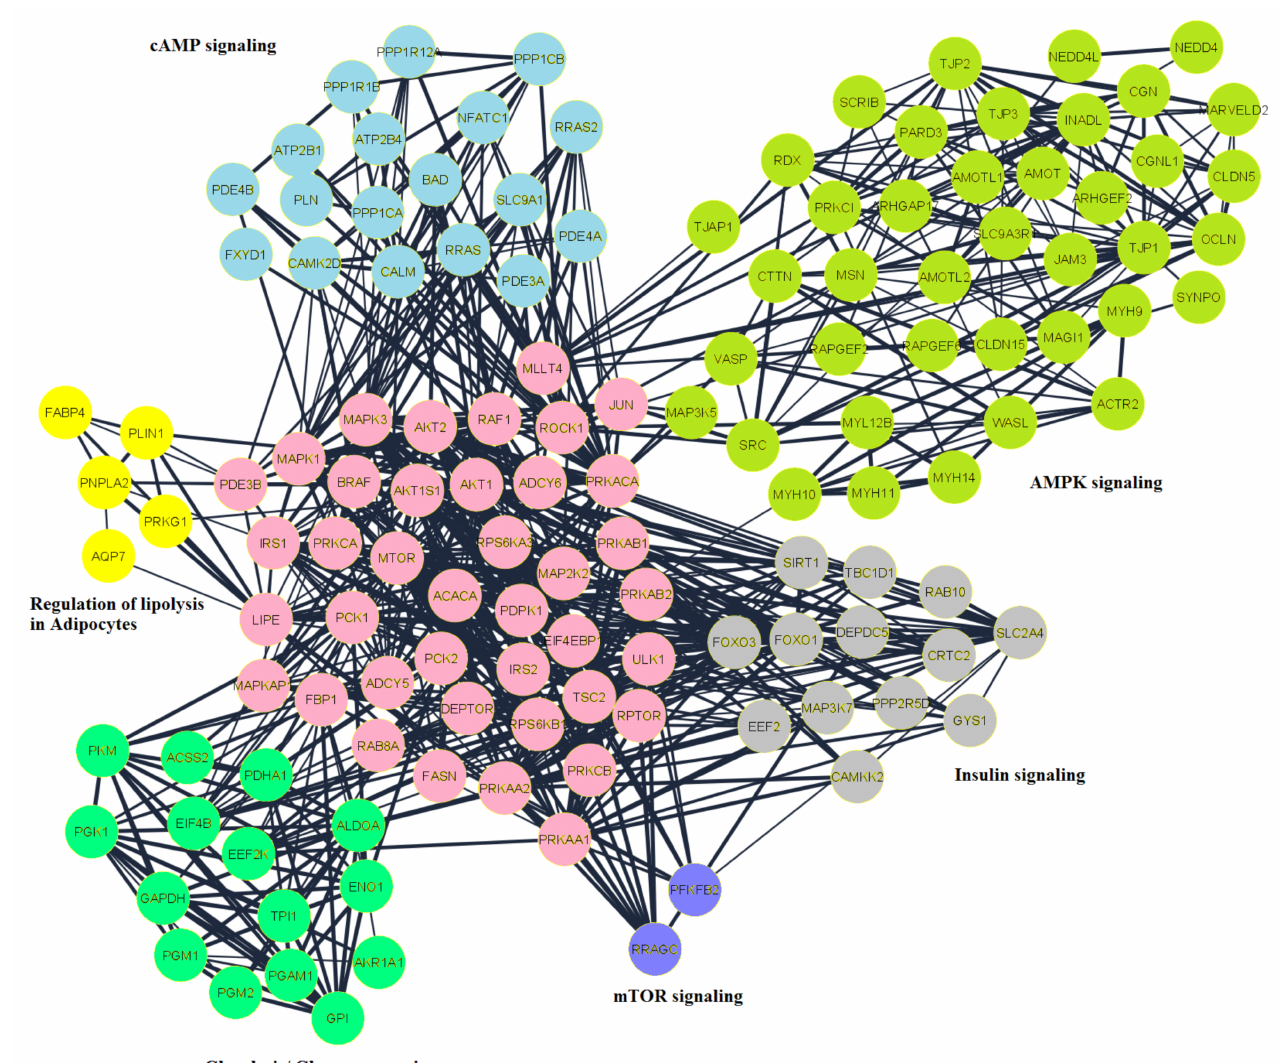
Figure 5. Network analysis of the peptides related to lipid turnover in SC and OM AT of CLA vs. CON was generated by Cytoscape software. The important networks of lipid turnover in adipocytes were developed using nodes of AMPK (light green), Insulin (grey), mTOR (purple), glycolysis (green). Acetyl-coA carboxylase-1 (ACACA), an important enzyme in the biosynthesis of fatty acids with seven upregulated phosphorylation sites, was noted in lipogenesis. Substantially upregulated was the main phosphorylation site at serine 78, indicating activation of ACACA in AT of cows supplemented with CLA. This phosphosite is a direct AMPK target and therefore matches well with the results of our kinase-substrate prediction that indicated reduced AMPK activity thus stimulating ACACA leading to lipogenesis in reaction to CLA supplementation. It is also important to note the observed downregulation of the phosphorylation of ABHD15, at serine 434 in our study, suggesting that this site may have regulatory mechanism in controlling the balance of lipids in lipid